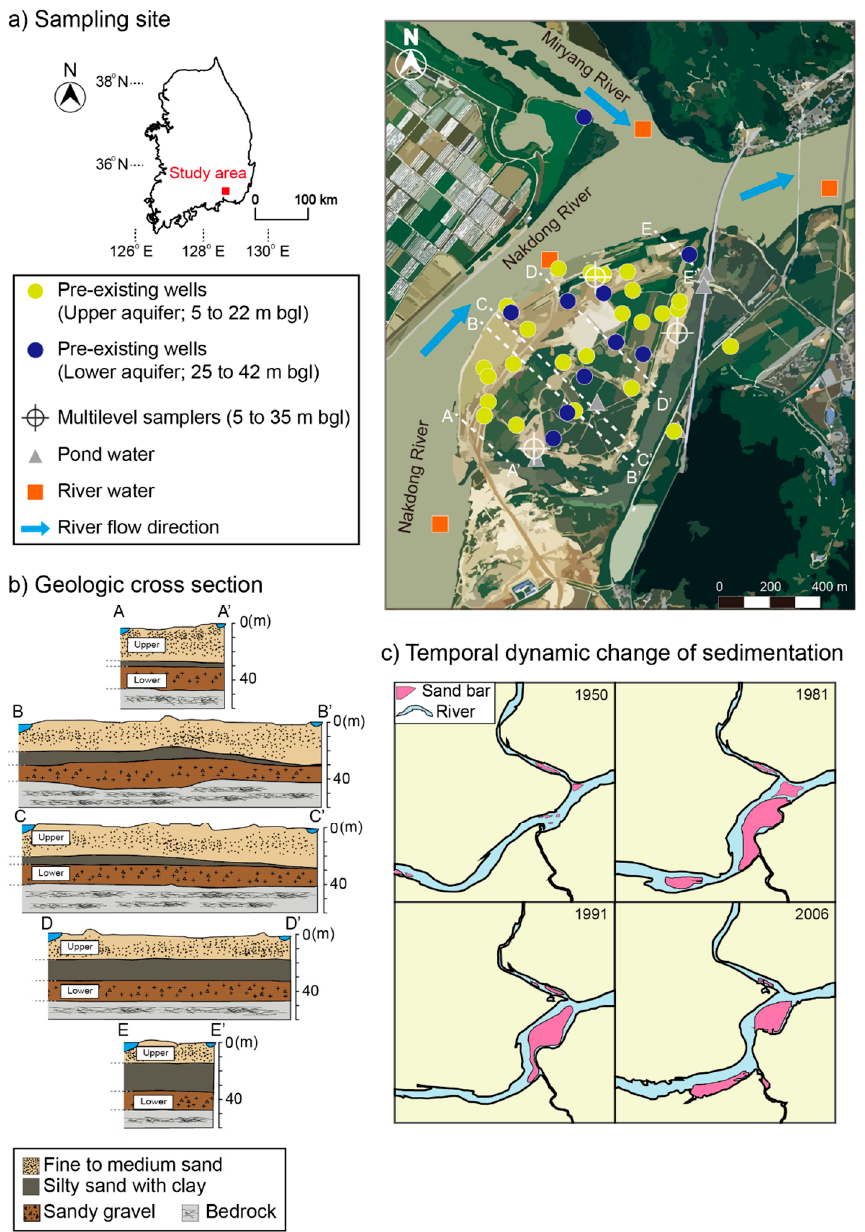
Figure 1. ( a ) Location of sampling sites in the study area at the lower reach of the Nakdong River, ( b ) The geological cross sections (A–A’ to E–E’ in ( a )), and ( c ) Temporal dynamic change of sedimentation (modified after Daewoo Construction Co. [47]). bgl = below ground level.